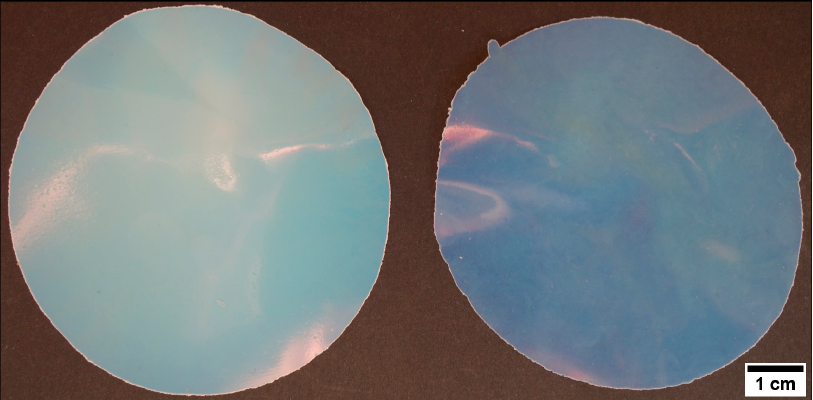
Figure 7. Opal film after melt-shear organization (140 °C, 160 bar, 180 s) of the PS- co -PALMA@P(EA- co -MPSEt) particles with a particle size of 289 nm ( left ) and 230 nm ( right ).